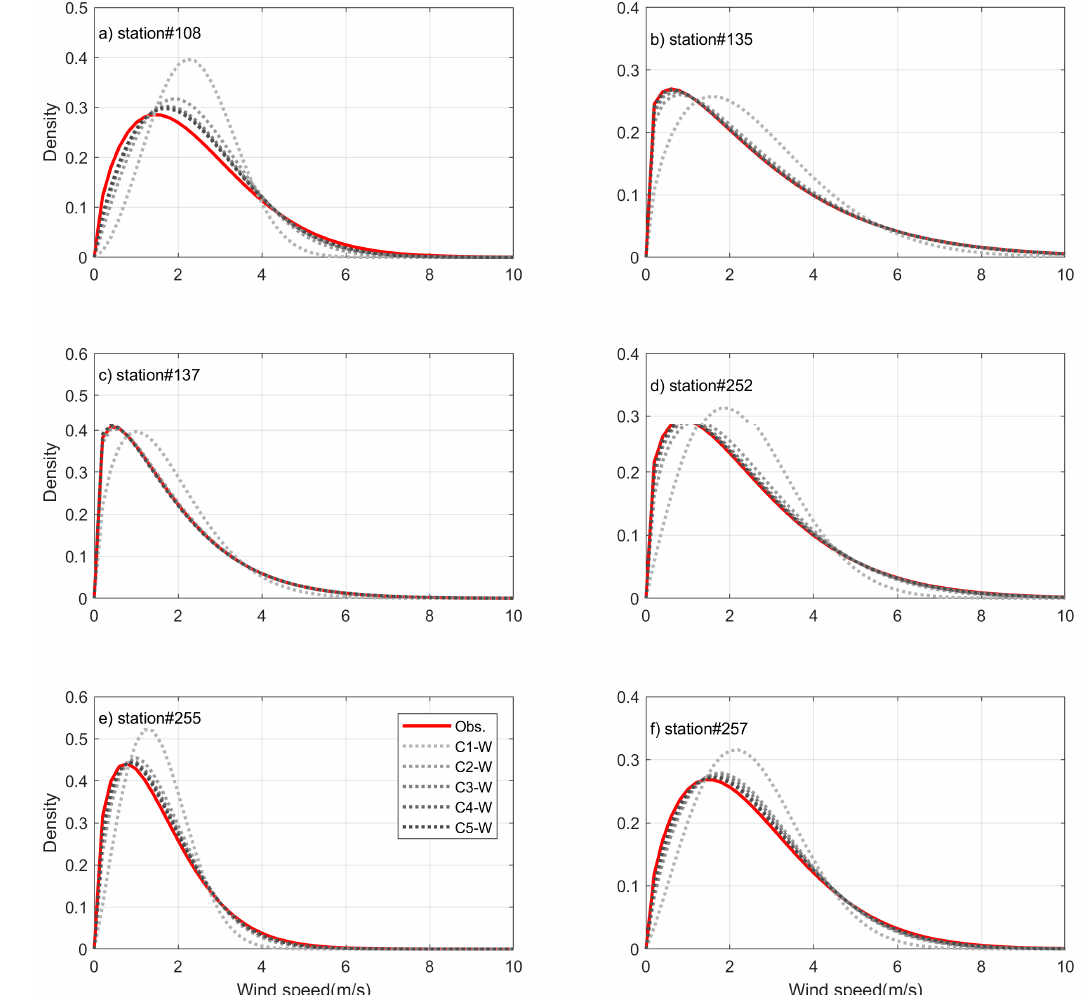
Figure 8. Probability density functions of the downscaled Weibull distributions with the WLS method for all the cases of stations ( a ) #108, ( b ) #135, ( c ) #137, ( d ) #252, ( e ) #255, and ( f ) #257. The red line indicates the Weibull PDF fitted by the method of moments for the hourly mean wind speed data. The observed distribution (red solid line) indicates the Weibull distribution of hourly wind speed data fitted using the method of moment.